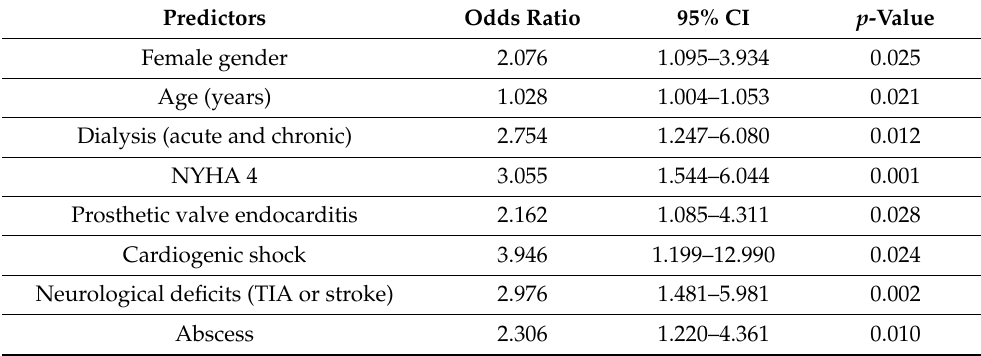
Table 4. Logistic regression analysis for 30-day mortality in endocarditis patients.